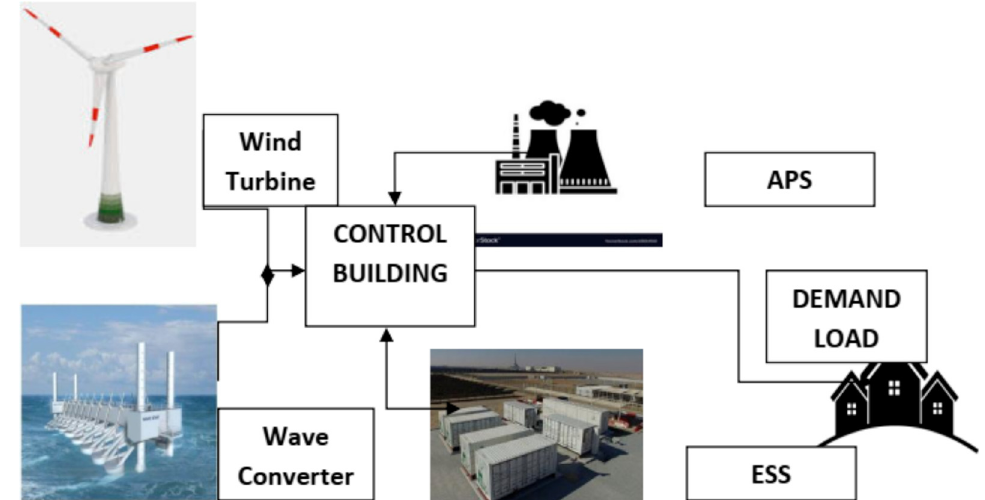
Fig. 5. Schematic representation of the proposed hybrid power